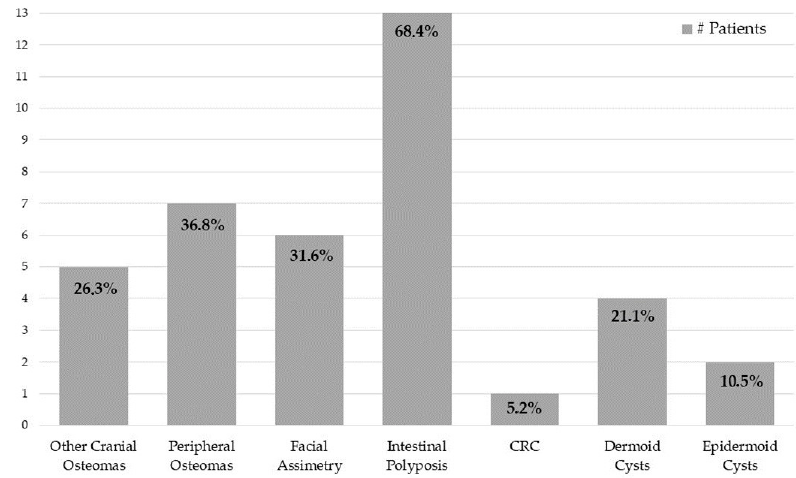
Figure 2. Extraoral characteristics in our GS patients.